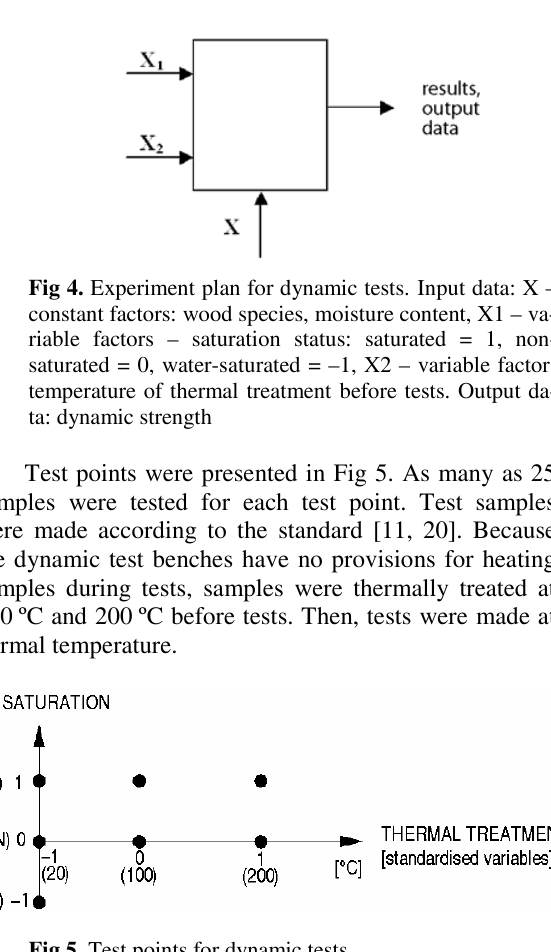
Fig 5. Test points for dynamic